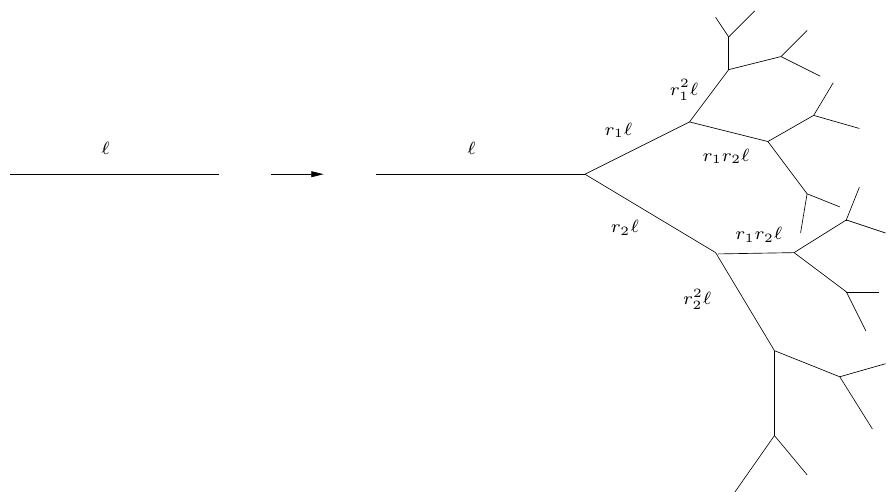
Figure 3. A branching structure which results from four applications of the branching generator shown in Figure